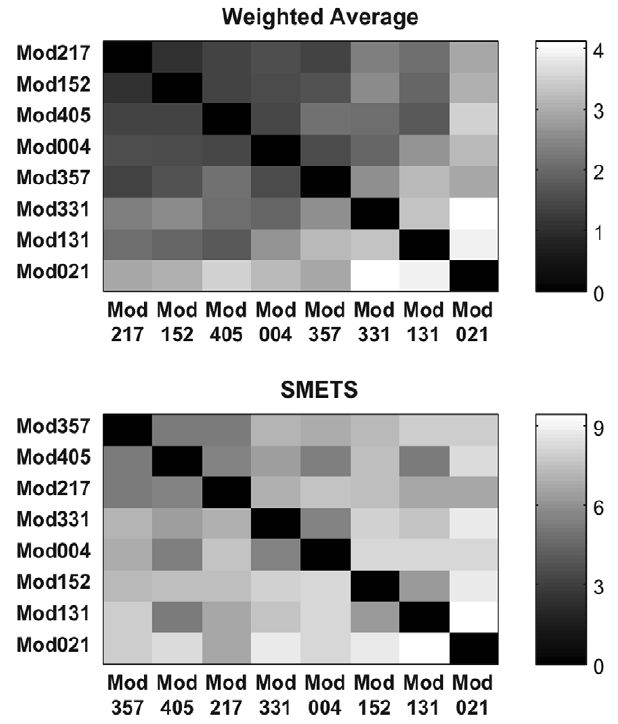
Figure 6. Distance matrices for the systems biology models. Distance values were measured using the average and SMETS distances and are encoded in grayscale.